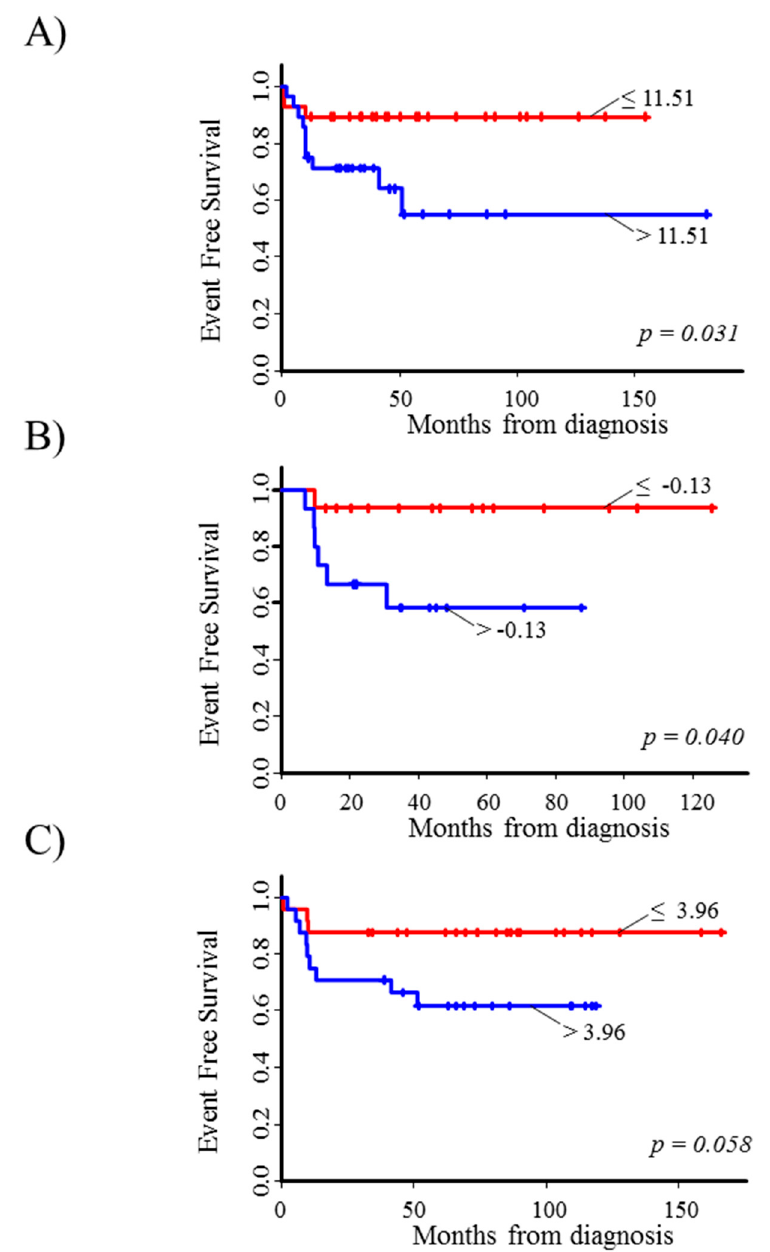
Figure 2. Event Free Survival curves of stage 4S neuroblastoma patients in relation to E2F3 gene expression levels in the three considered microarray datasets. ( A ) Kocak-649; ( B ) Oberthuer-251; ( C ) SEQC-RPM. Patients were split into two groups (red line: lower values; blue line: higher values) on the basis of the median value of gene expression (reported near the corresponding curve).